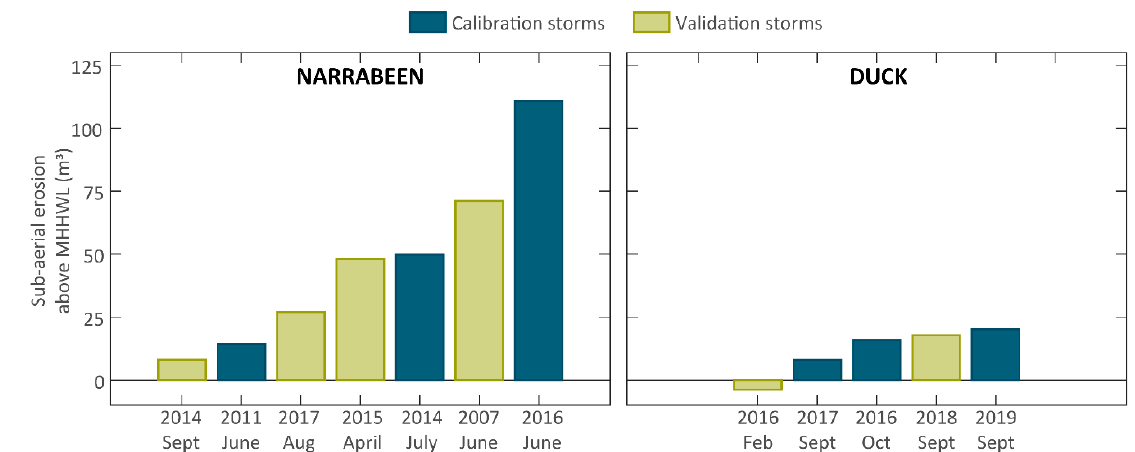
Figure 4. Storm events used for XBeach modelling at Narrabeen ( left ) and Duck ( right ) distinguished in terms of storms used to calibrate the model and storms used to validate the skill of the fully calibrated XBeach model. The storm events are sorted from left-to-right by the observed sub-aerial erosion above MHHWL.